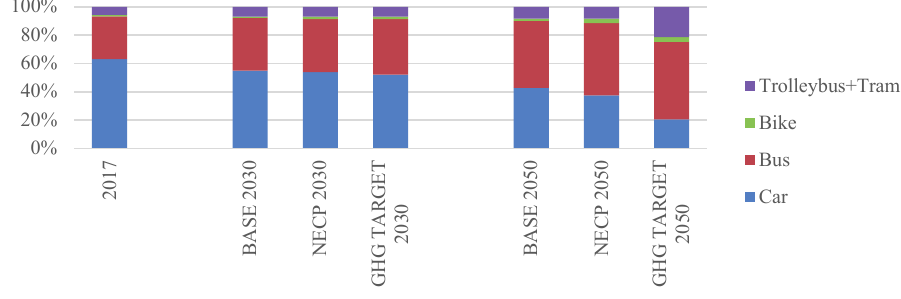
Fig. 16. Structure of modes of passenger transport for medium